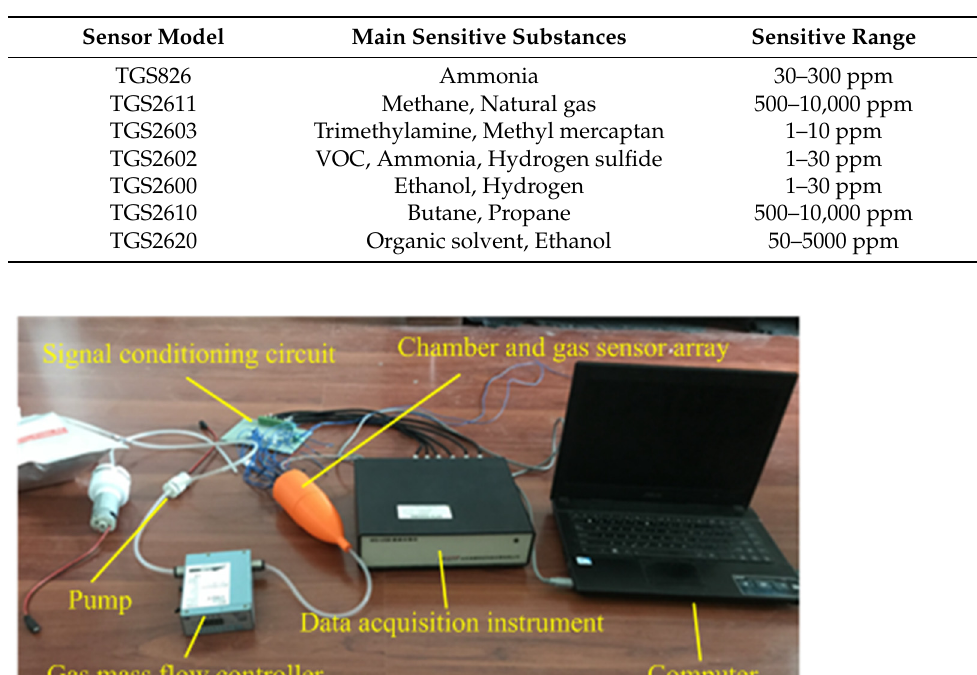
Table 1. Sensor models and characteristics of electronic nose.